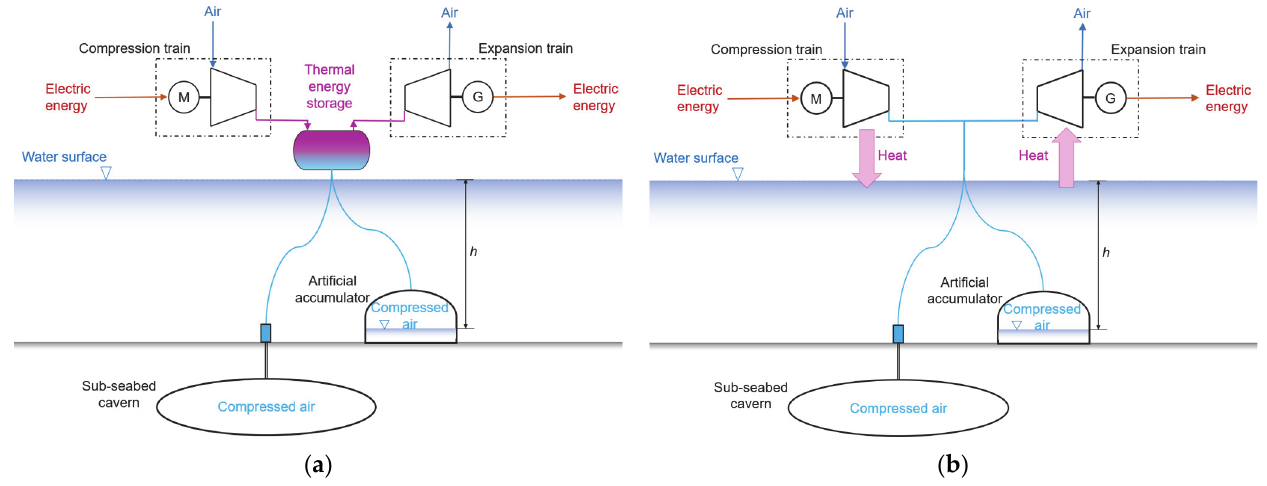
Figure 1. Schematic diagrams of UWCAES: ( a ) UWCAES with adiabatic compression and expansion; ( b ) UWCAES with isothermal compression and expansion.